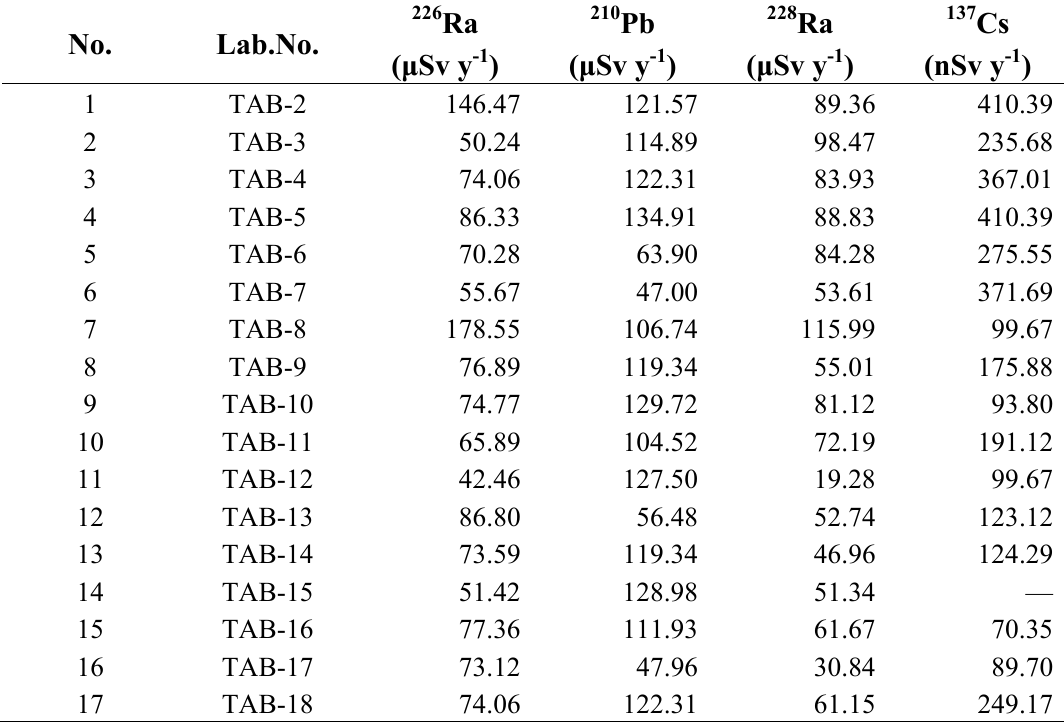
Table 3. Annual effective dose of smokers in smoking 30 cigarettes per